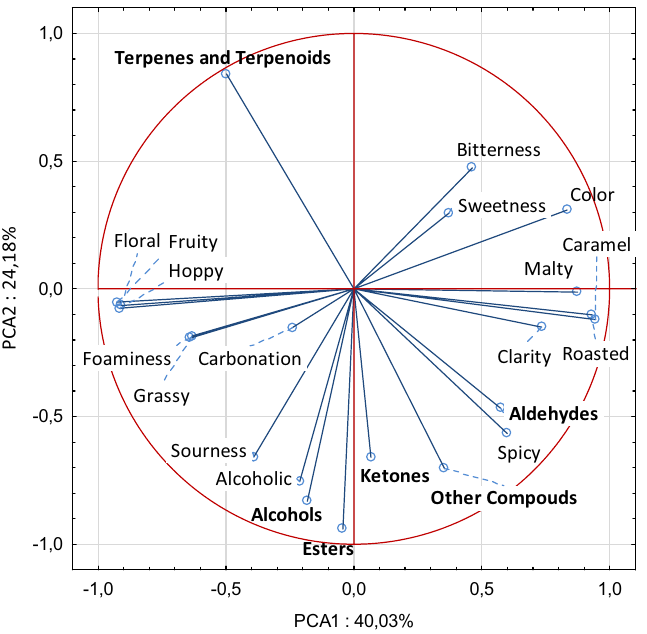
Figure 2. Principal component analysis (PCA) of groups of volatile compounds and beers sensory